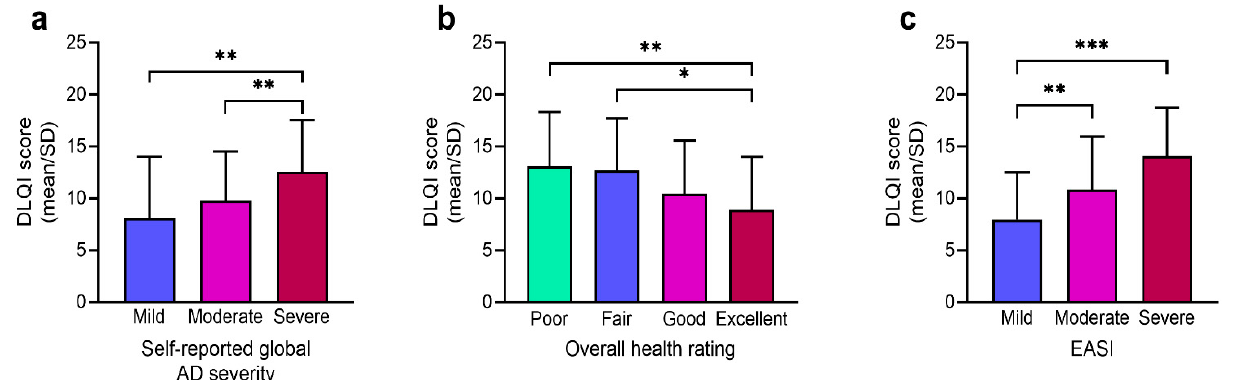
Figure 2. Bivariate association between the overall DLQI score (expressed as mean/SD) and subgroups of ( a ) self-reported global AD severity, ( b ) overall health rating, and ( c ) the EASI. EASI categorized as: scores <9 (mild), 9–15 (moderate), and >15 (severe). DLQI: Dermatology Life Quality Index; EASI: Eczema Area and Severity Index; AD: atopic dermatitis. *** p < 0.001; ** p < 0.01; * p < 0.05. note: A higher DLQI value indicates a poorer HRQoL.